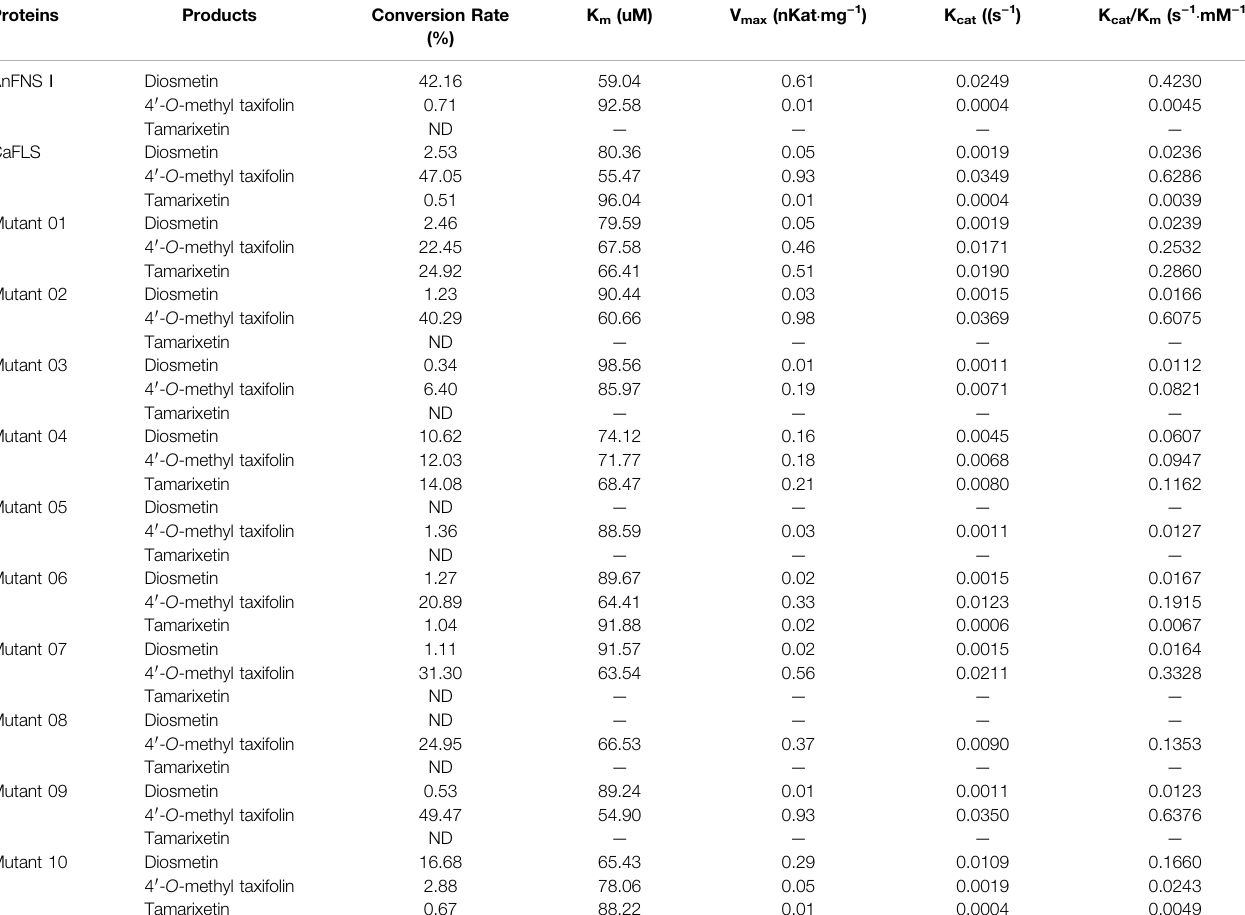
TABLE 5 | Products conversion rate in bioconversion assay and catalytic activity in vitro . Proteins